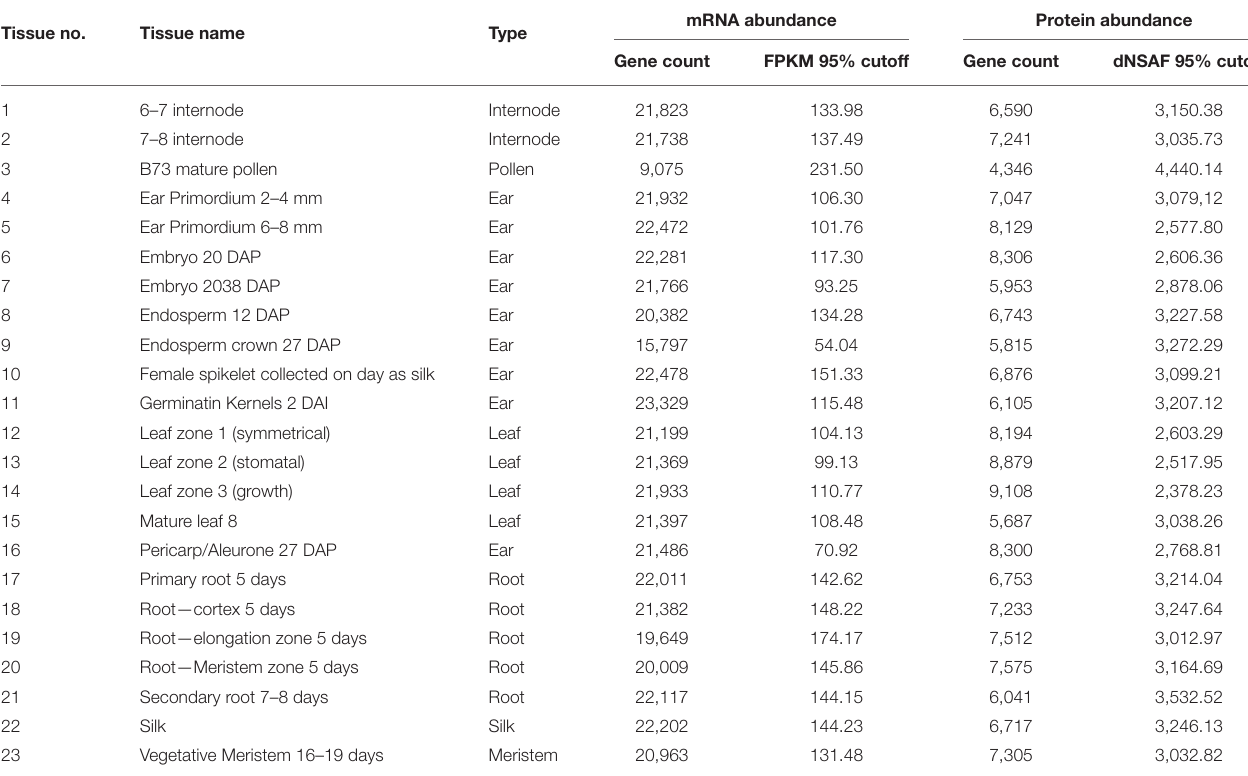
TABLE 1 | A table describing the developmental atlas of maize data set. Tissue